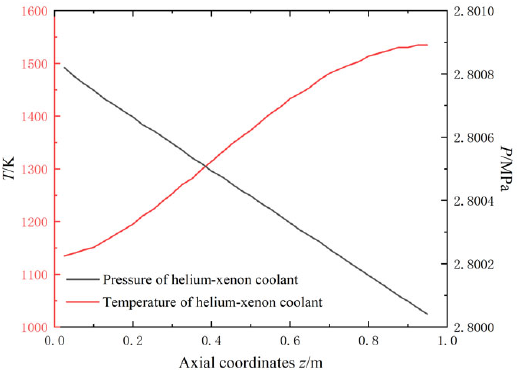
Figure 8. Pressure and temperature distribution of helium–xenon coolant in the channel [20].